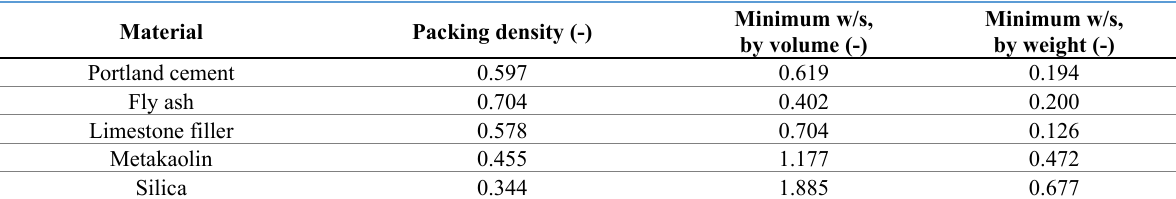
Table 7. Packing density and water demand of Portland cement and mineral